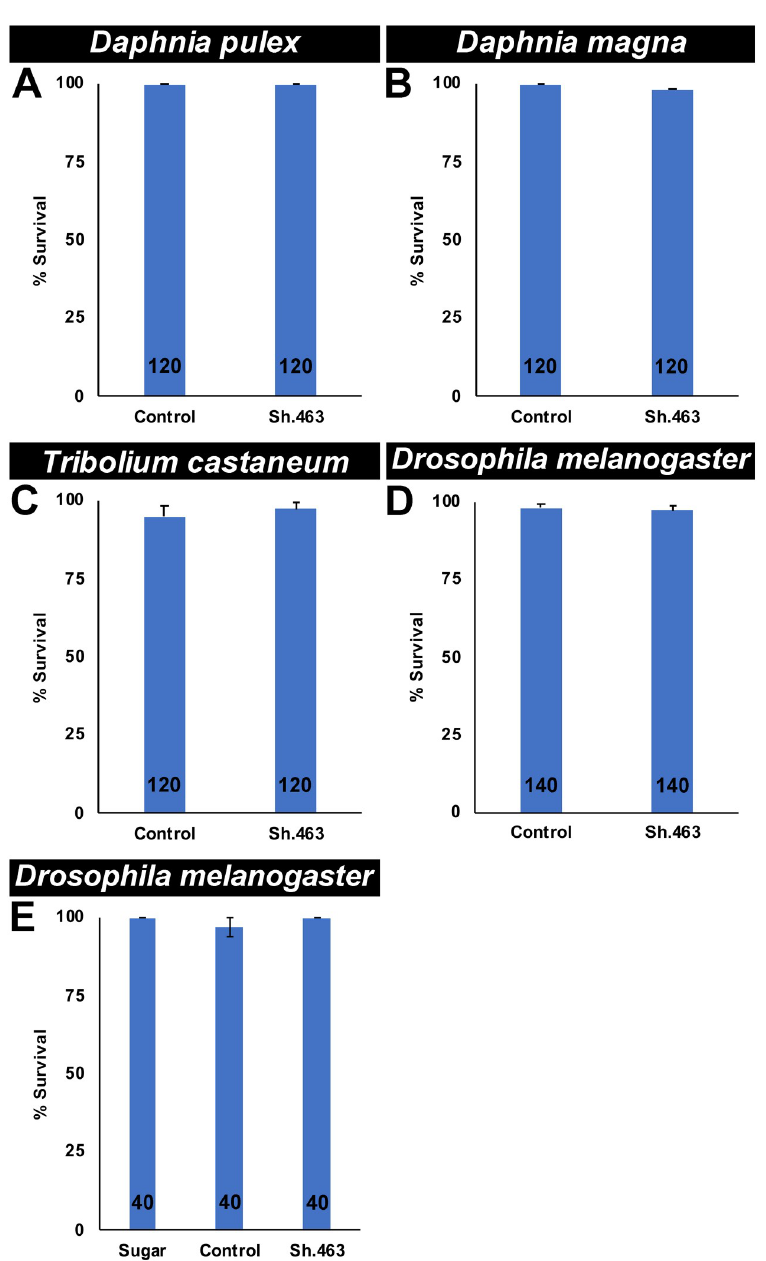
Fig 7. Four non-target arthropods survive Sh.463 IRP treatment. Survival was assessed following consumption of Sh.463 yeast IRP by D . pulex adults (A), D . magna adults (B), T . castaneum larvae (C), and D . melanogaster larvae (D). Adult D . melanogaster fed with Sh.463 siRNA, control siRNA, or sugar bait alone survived (E). Graphs display mean percentages of survival, with error bars denoting SEM. No significant differences in survival data were identified in any of these assays